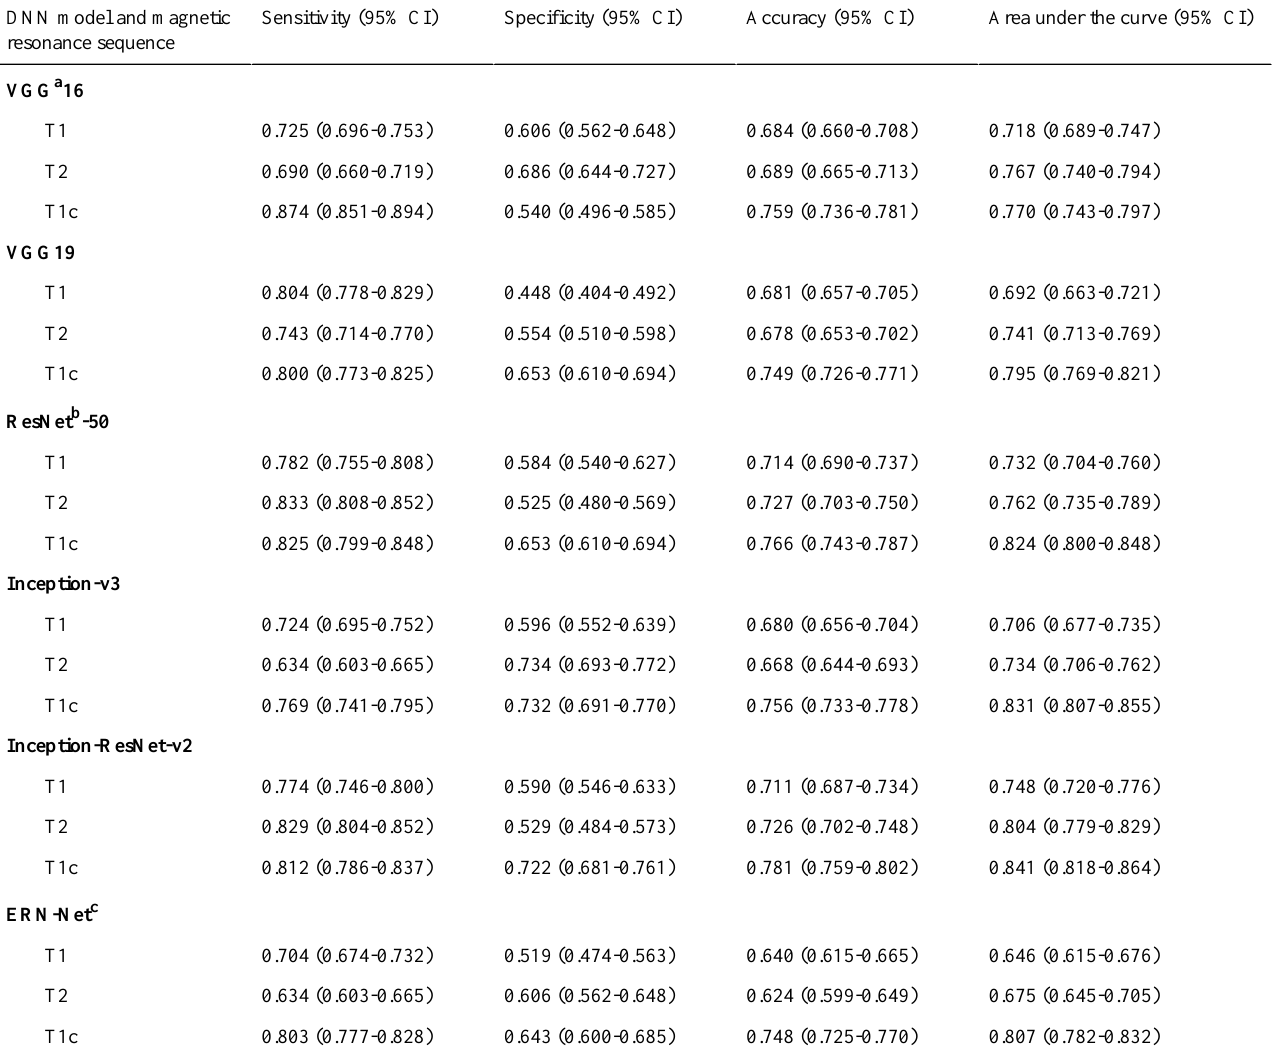
Table 3. Performance of the deep neural network (DNN) models on individual magnetic resonance imaging (MRI) sequences: T1-weighted MRI (T1), T2-weighted MRI (T2), and gadolinium-contrast-enhanced T1-weighted MRI